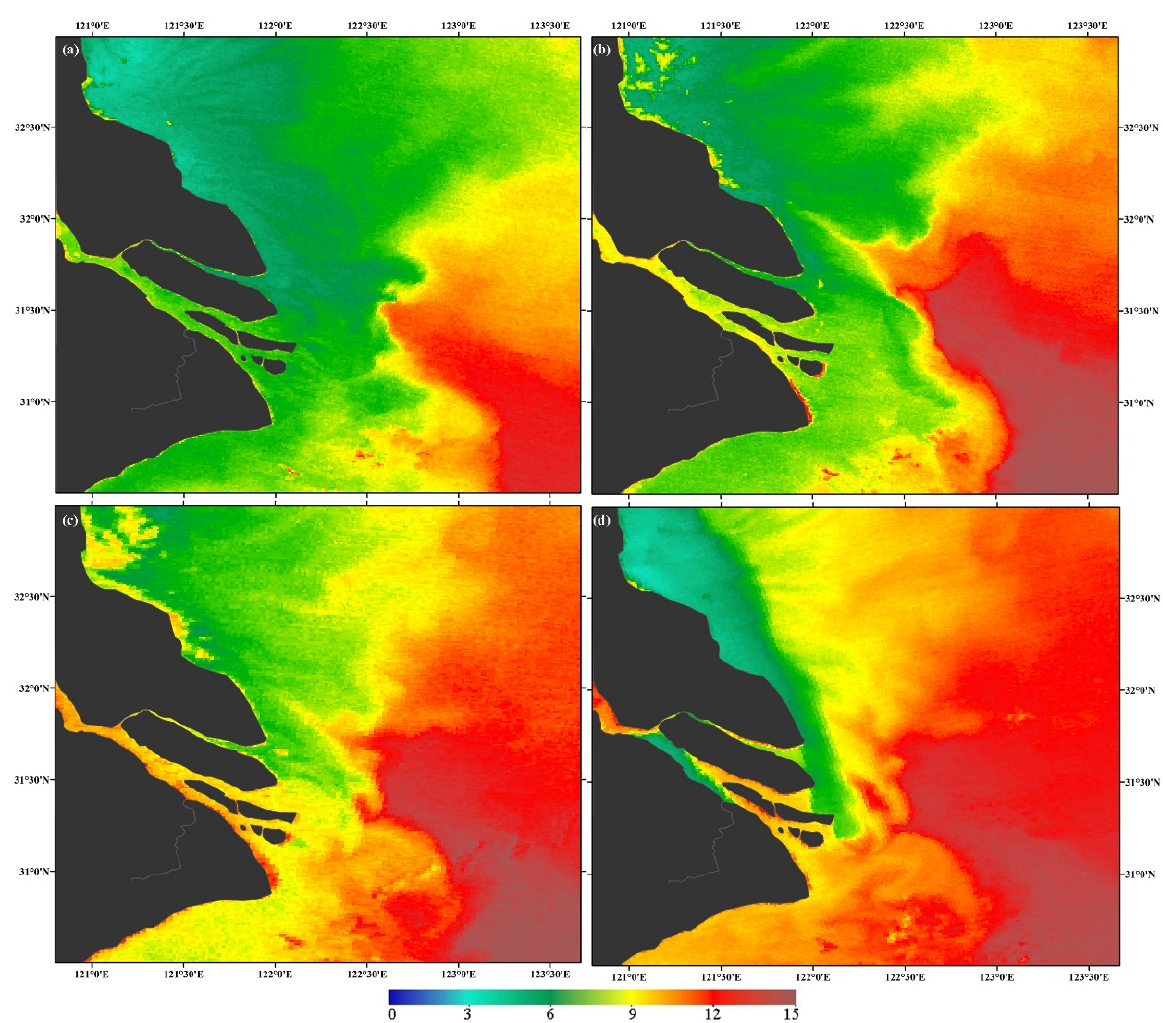
Figure 3. Characteristics of the SST field in the Yangtze Estuary before the cold wave (where ( a – d ) is 4 January 2015 (one day before the cold wave), 29 December 2014 (two days before the cold wave), 23 December 2021 (one day before the cold wave), and 22 December 2021 (two days before the cold wave), respectively).